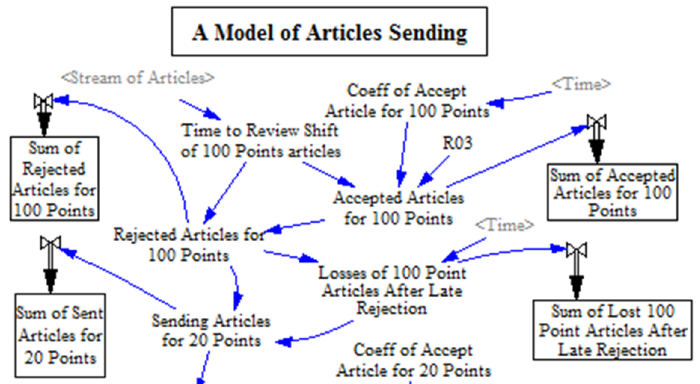
Figure 8. Vensima model of paper submission. The part referring to the first stage: submitting to 100-point journals and reacting to possible rejections.